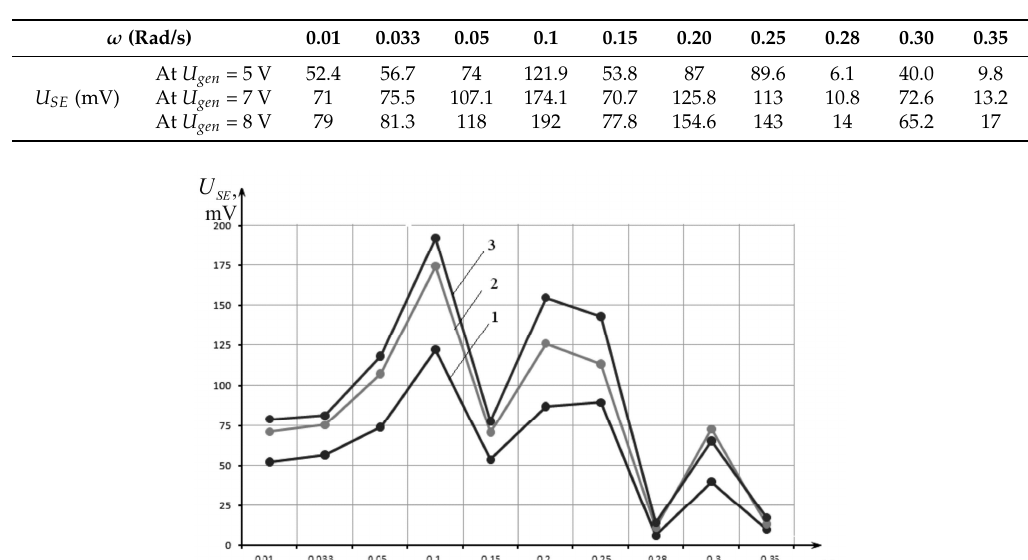
Table 1. The experimental data.